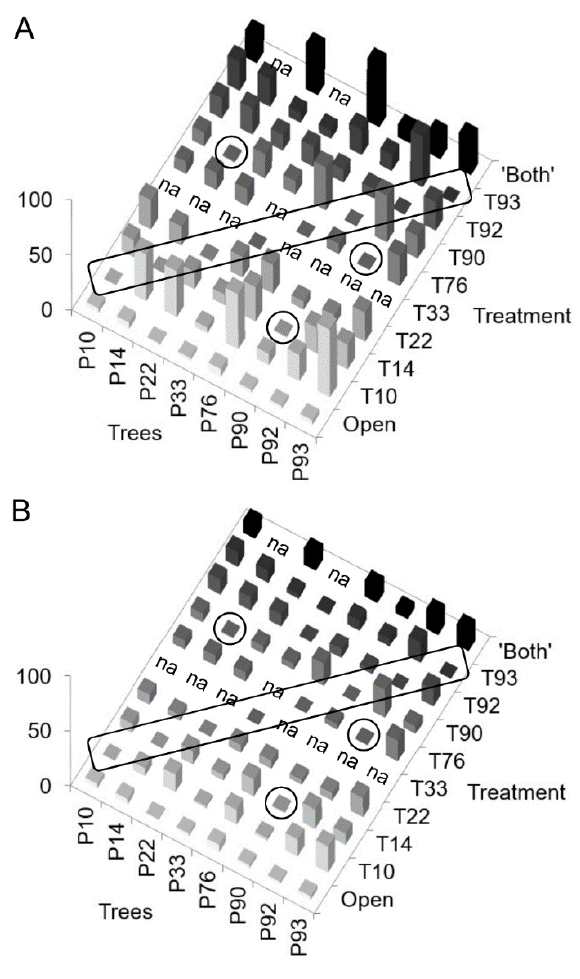
F IGURE 1. Overview of the number of immature (A) and mature (B) pods per hermaphroditic capitula for Parkia biglobosa, distributed on treatments (i.e. pollen donors) and trees. The box encompasses the events of self-pollination, which all resulted in very few pods, and the circles indicate low numbers of pods resulting from cross- pollinations. ‘Open’ indicate open -pollination (control) and ‘Both’ is a treatment in which capitula were pollinated with self - pollen on one half and cross-pollen on the other half. However, ‘Both’ yielded exclusively outcrossed pods. Pollen donor T33 was only applied to tree P33, pollen donor T76 was applied to only functionally male capitula on tree P33 and neither tree P14 or tree P33 had not enough capitula for the ‘Both’